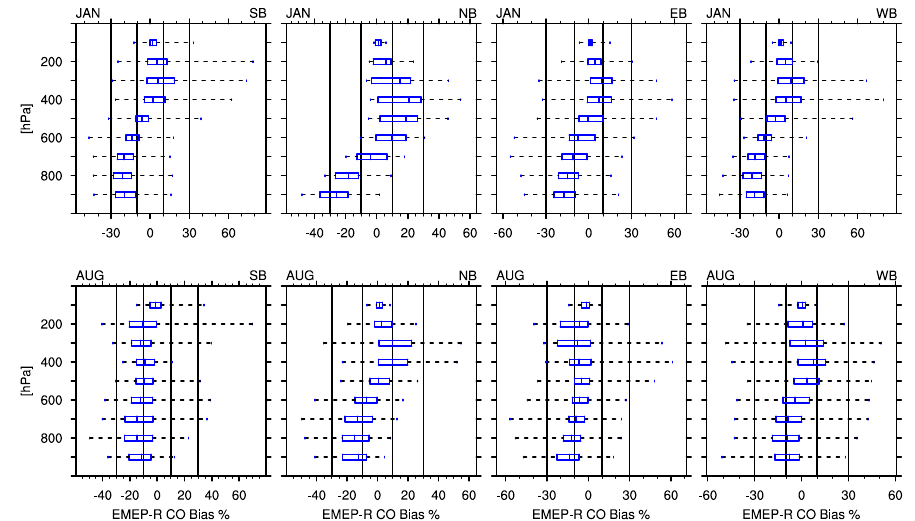
Figure 3. Retrieved bias for each altitude, shown as box plots, between EMEP and MOPITT for CO and the same months and cardinal boundaries as Fig. 2. The blue boxes corresponds to the interquartile range, the black dotted lines show the range of bias at each altitude, the blue line within each box represents the median. The four black vertical lines show the ± 10 and ± 30% bias